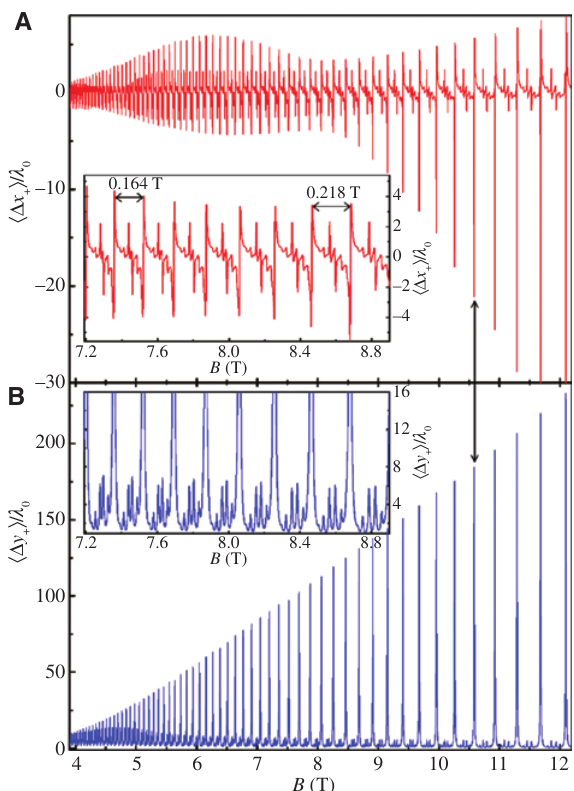
Figure 6: (A) In-plane and (B) transverse spin-dependent shifts on the surface of monolayer BP film as a function of the magnetic field = 55.6 ° . B when ħ ω = 1.8 eV and θ i The insets show partially magnified photonic spin Hall shifts for clarity. The arrow pointing top and bottom indicates that both ⟨ Δ x and ⟨ Δ y ⟩ give one of their extreme values at about 10.582 +